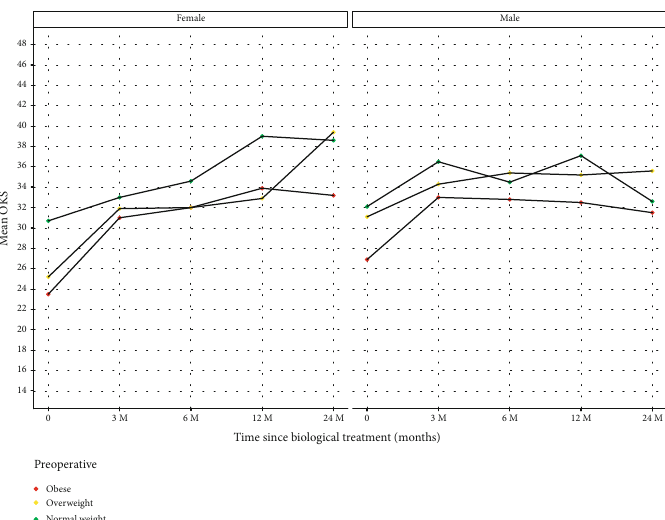
Figure 8: Patients grouped by BMI at time of treatment (baseline) with follow-up OKS at 3, 6, 12, and 24 months. x -axis: time points in relation to treatment: baseline prior to treatment (0), 3, 6, 12, and 24 months posttreatment. y -axis: OKS mean for each group. Red: obese ( BMI ≥ 30 ). Yellow: overweight ≥ 25 BMI < 30 ). Green: healthy weight ( BMI < 25 )